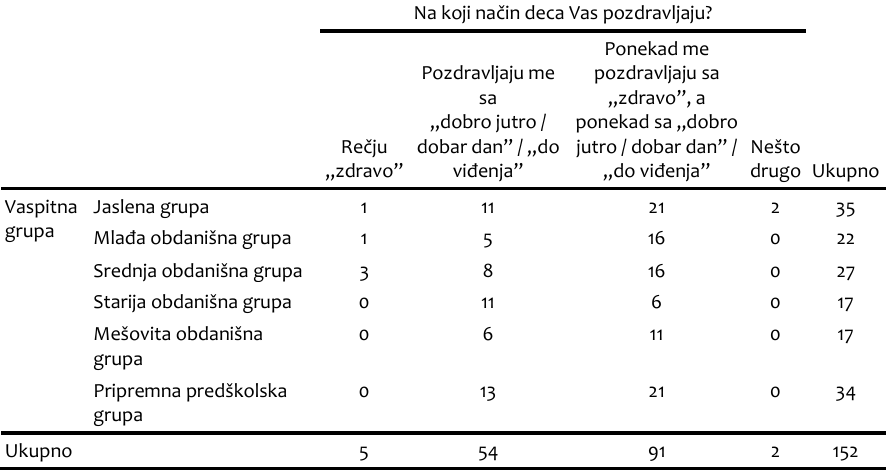
Tabela 4). Tabela 4. Najčešća neverbalna sredstva pozdravljanja među decom u predškolskoj ustanovi Neverbalna sredstva pozdravljanja